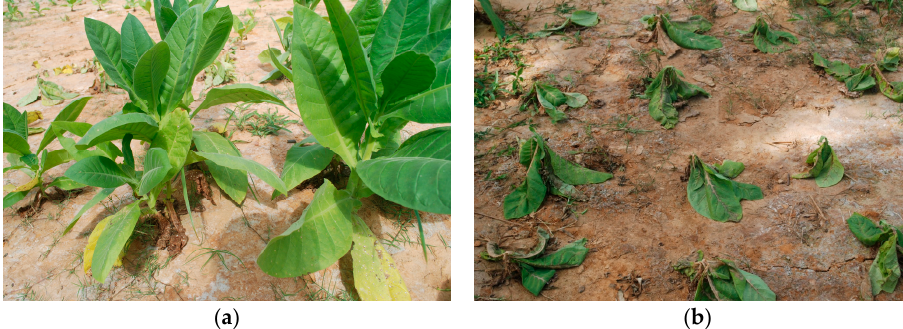
Figure 2. Tobacco plants before ( a ) and after ( b ) irrigation of the tailings surface with NaCN.